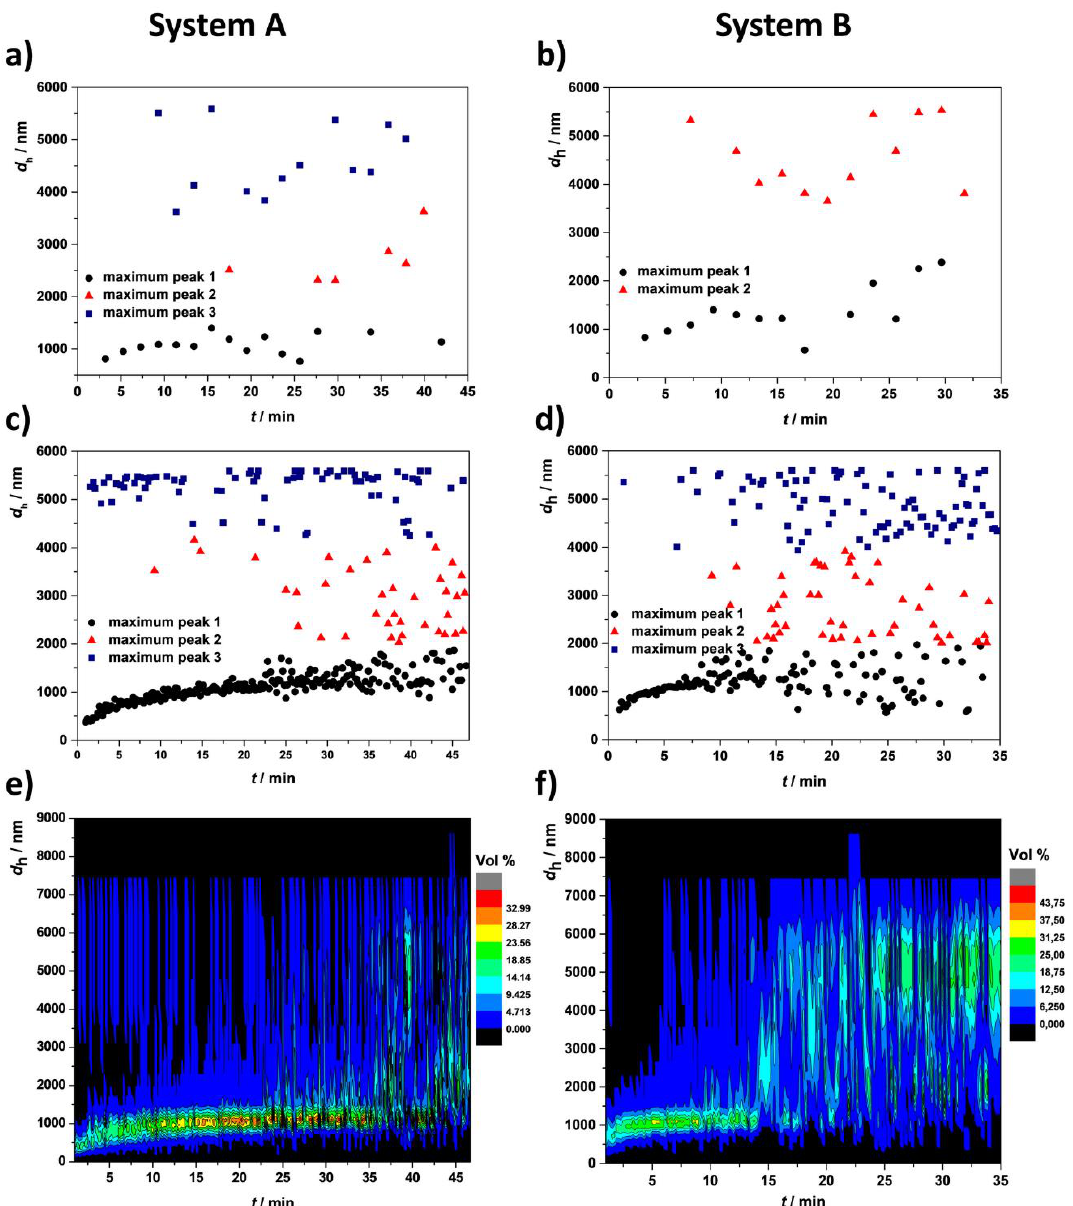
Figure 3. Changes of hydrodynamic diameter ( d h ) ( a – d ) and vol. % ( e – f ) of particles formed in system A ( c (CaCl 2 · 2H 2 O) = c (Na 2 HPO 4 ) = 3.5 mmol dm − 3 ) and B ( c (CaCl 2 · 2H 2 O) = c (Na 2 HPO 4 ) = 4.0 mmol dm − 3 ) without stirring measured by DLS. ( a , b ) time averaged experiment and ( c – f ) time resolved experiment. pH init = 7.4, ϑ = 25.0 ± 0.1 °C.